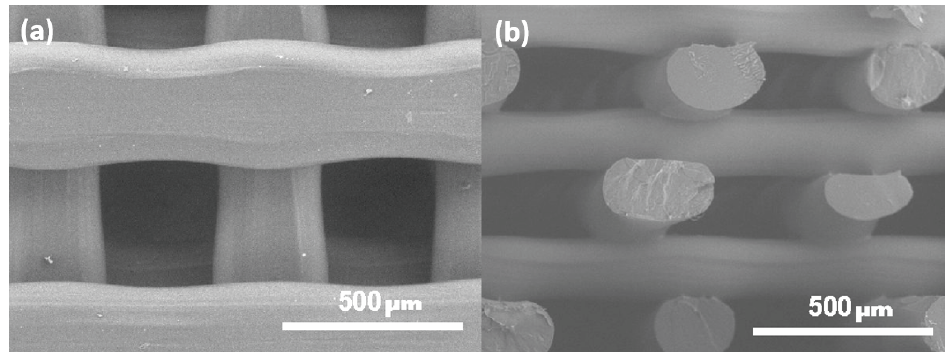
Figure 4. SEM micrographs of printed PLA-micro-log pile (woodpile) structure: ( a ) top view, lateral period 700 µ m and line widths of 300 µ m separated by 400 µ m gaps; ( b ) side view; the axial period was 400 µ m and line heights of 200 µ m separated by 200 µ m